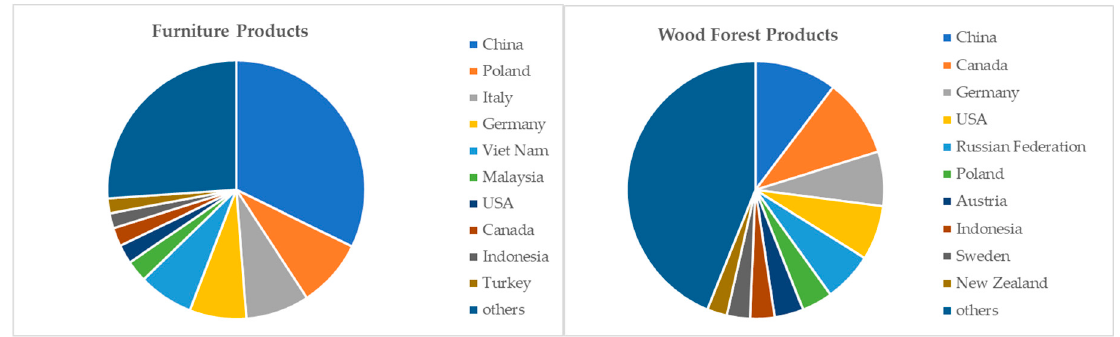
Figure 3. Export market of furniture products and wood forest products in 2018. Date source: UN Comtrade.